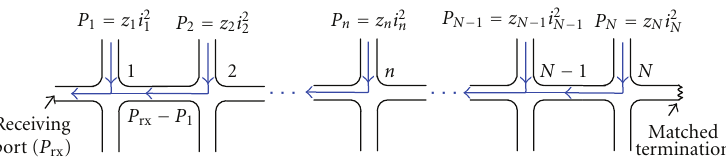
Figure 25: Coupling and transmission coe ffi cients of the